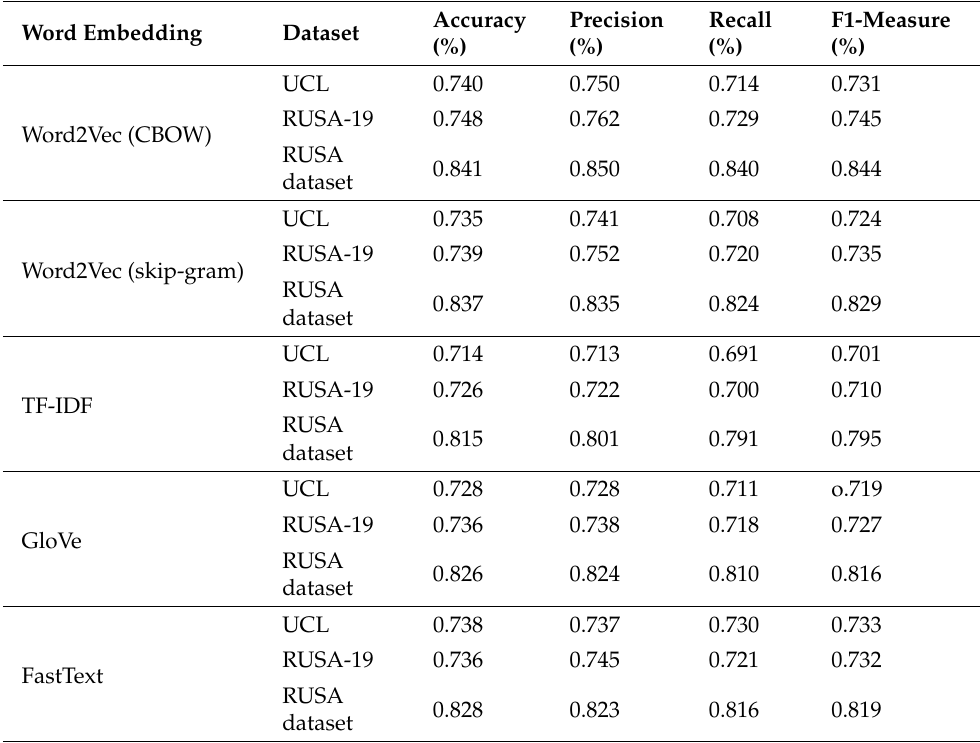
Table 7. CNN-LSTM Roman Urdu model accuracy using various word embeddings with two- layer